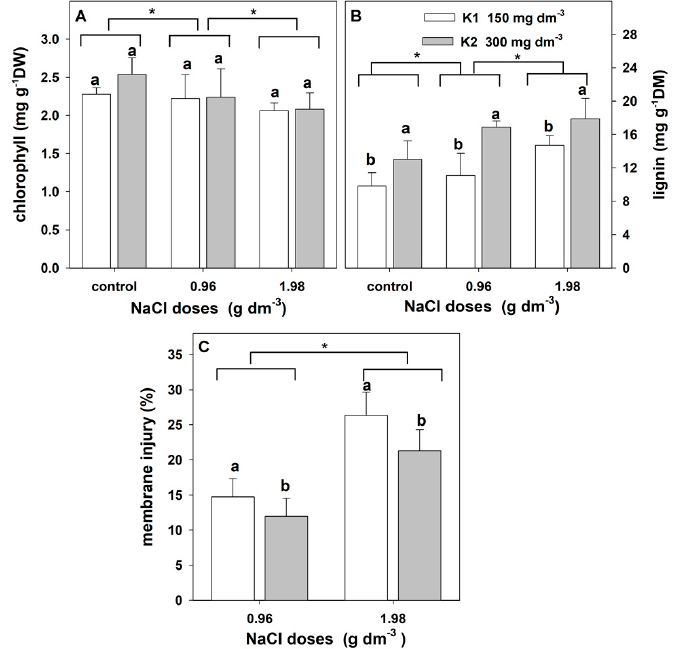
Figure 7. The effect of salinity doses on chlorophyll levels, lignin levels, and membrane injury index in the leaves of zinnia grown in the peat substrate supplemented with two doses of potassium. Letters a and b show a significant effect of K doses, and an asterisk (*) shows a significant effect of salt doses. Values are expressed as the means (n = 5) ± standard deviation.